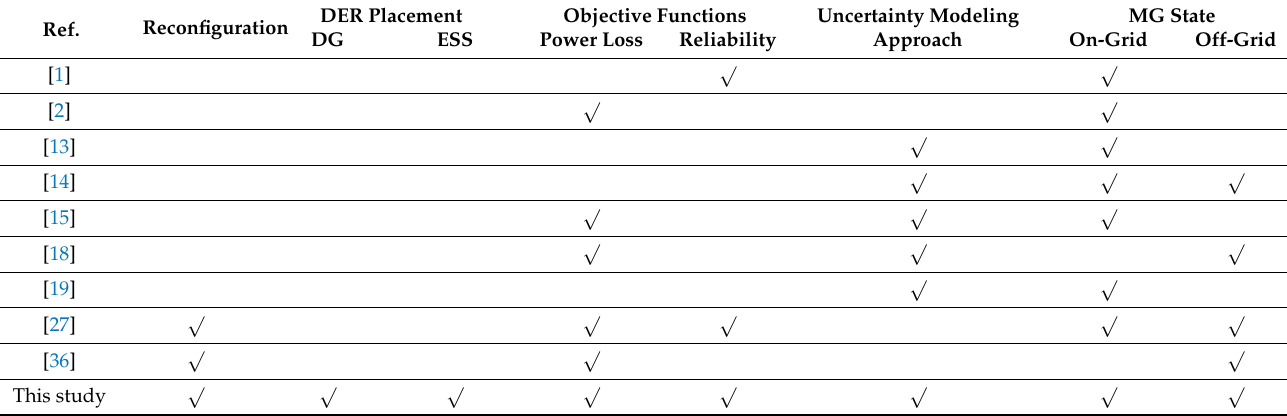
Table 1. Taxonomy of available literature on MG